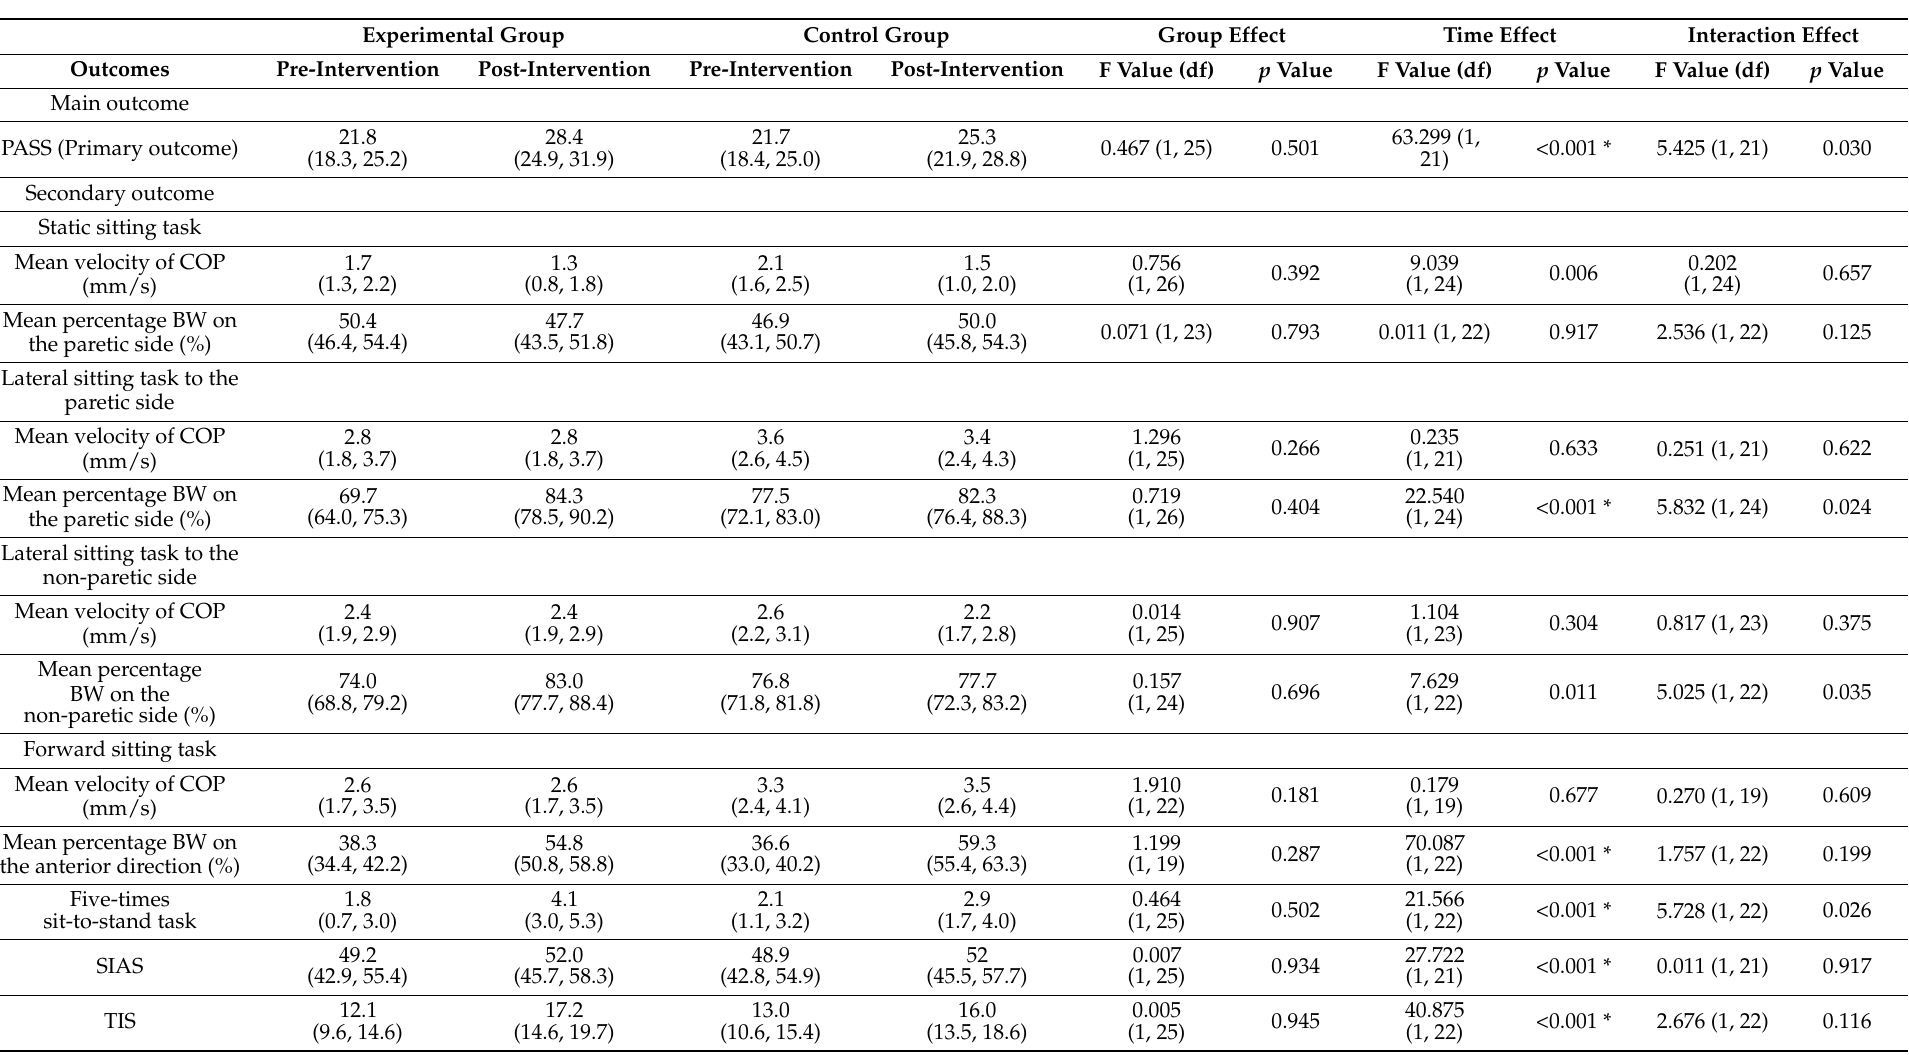
Table 2. Differences in outcomes between the two